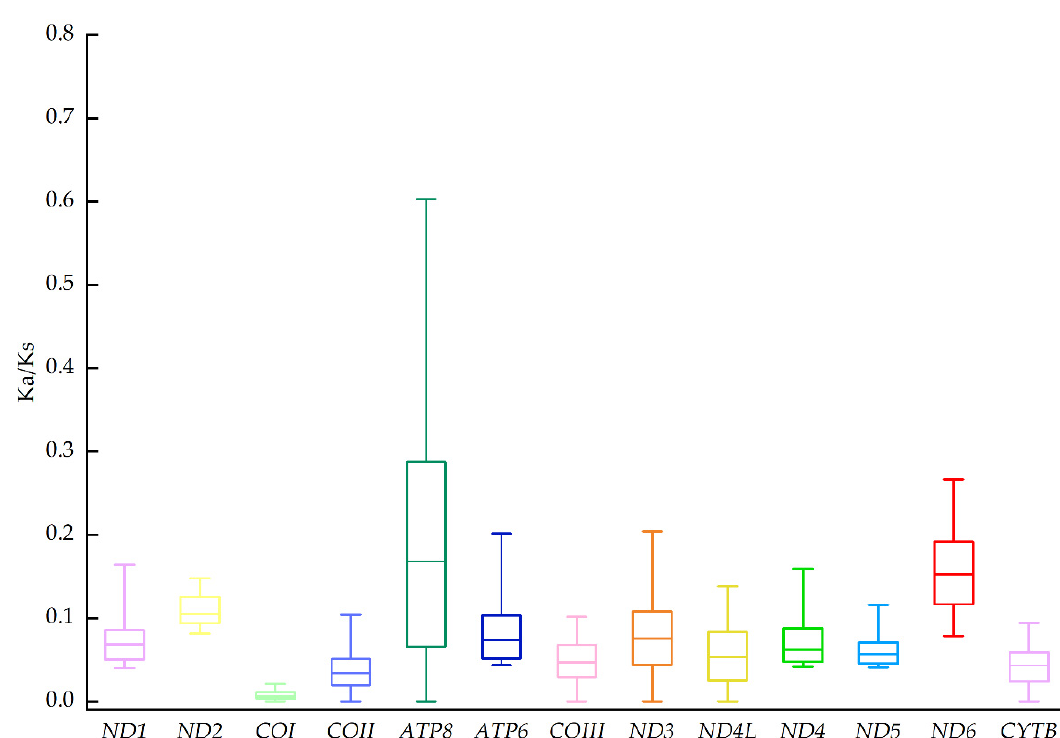
Figure 4. The Ka/Ks ratio of 13 PCGs among 12 species of Tylototriton .